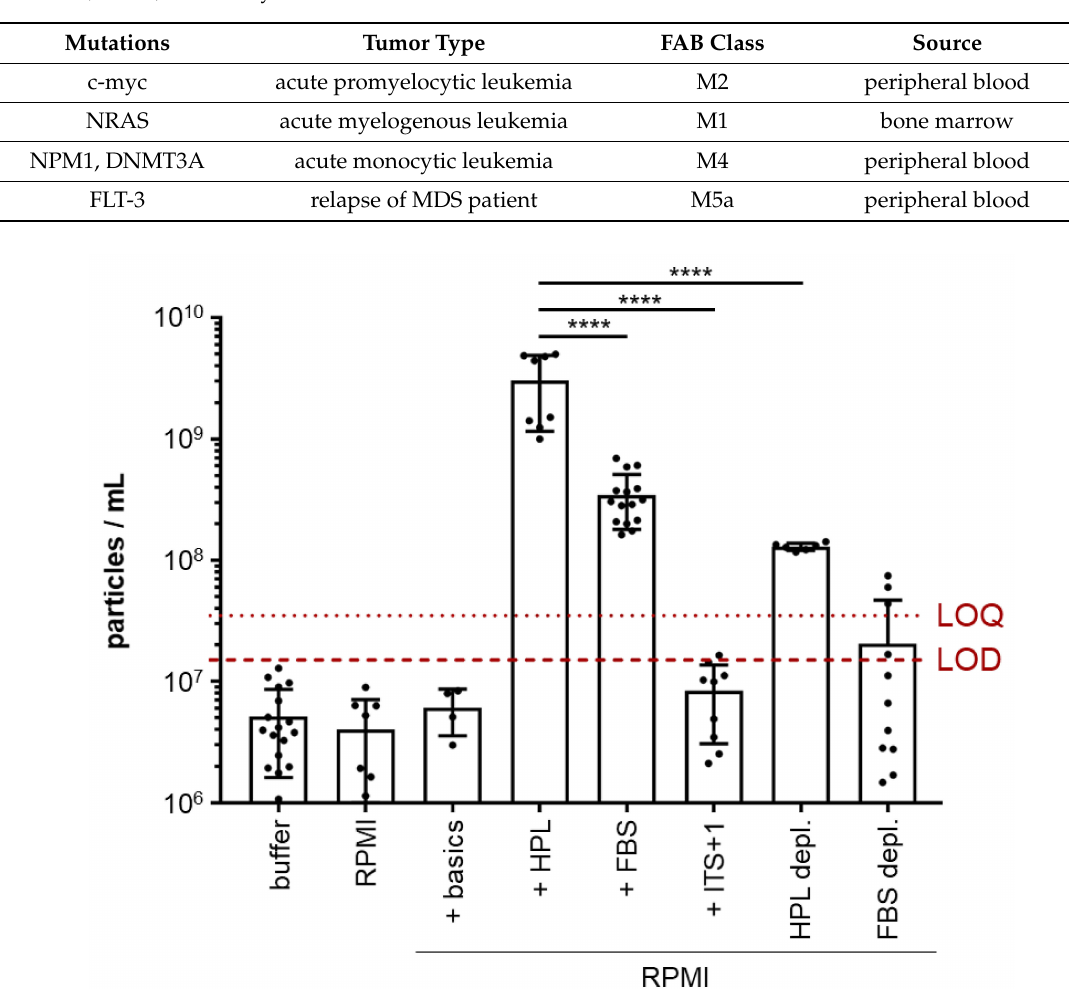
Table A1. Comparison of AML cell lines used in this study. Listed are the common name, typical mutations, AML type, French-American-British (FAB) classification [69]. Abbreviations: c-Myc, human cellular homolog of avian Mye- locytomatosis virus gene; NRAS, neuroblastoma RAS viral oncogene homolog; NPM1, nucleophosmin 1; DNMT3A, DNA-Methyltransferase 3A; FLT-3, fms-like tyrosine kinase 3.